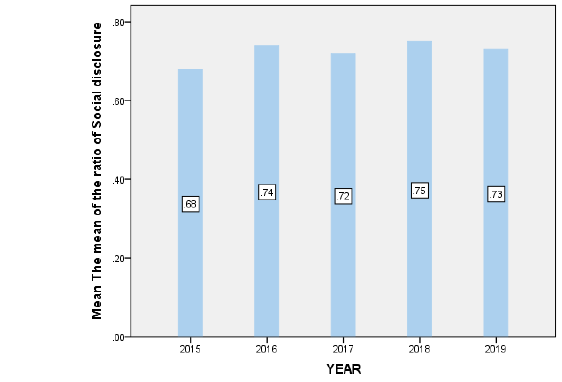
Fig 1 . The mean values of CSD dimensions Fig. 2. The mean values of CSD by years